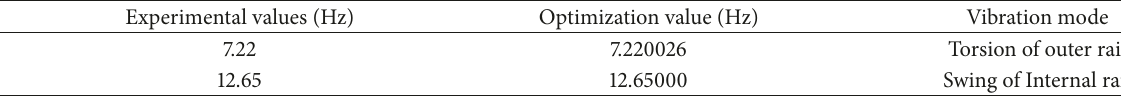
Table 2: The natural frequency of the rail model after optimization.